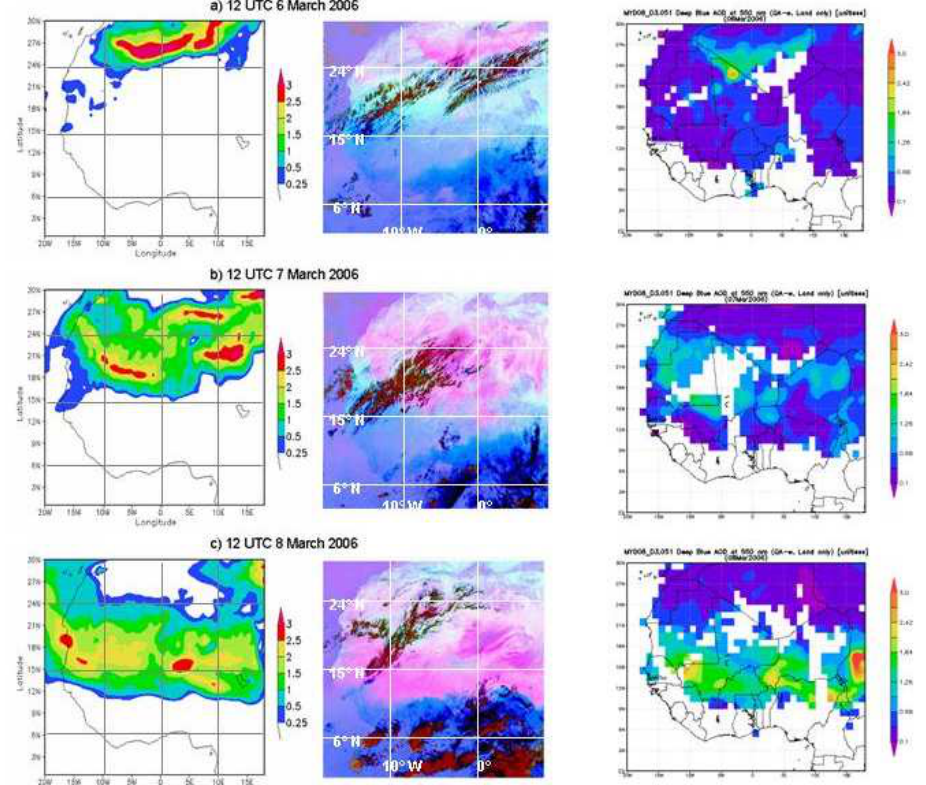
Fig. 3. Simulated AOD at 450nm of run F (left) and SEVIRI RGB dust product with dust shown in pink and cold high clouds in dark red Figure 3: Simulated AOD at 450 nm of run F (left) and SEVIRI RGB dust product with dust (middle) and MODIS deep blue AOD retrievals at shown in pink and cold high clouds in dark red (middle) and MODIS deep blue AOD retrievals at 550 nm .